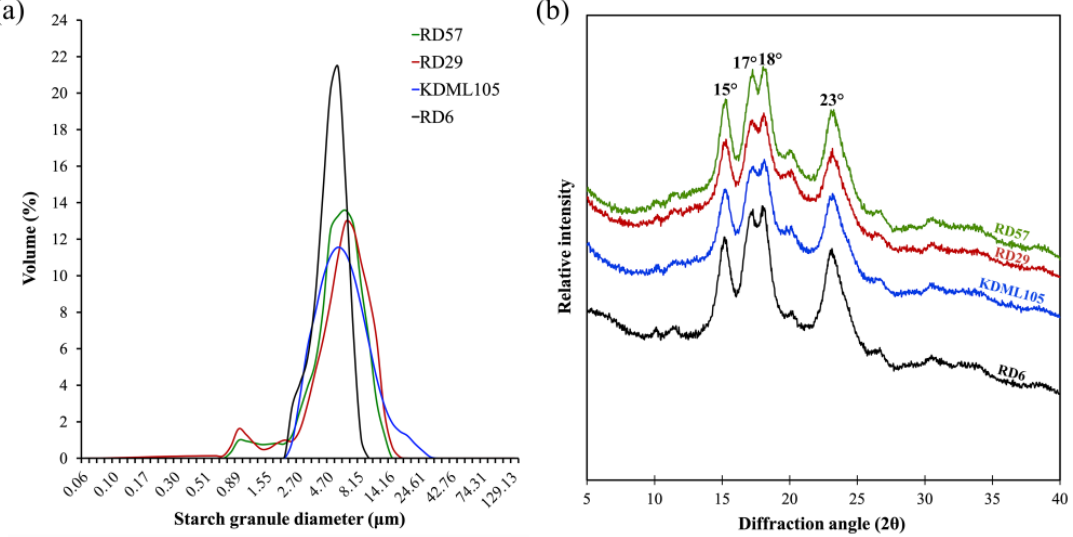
Values are means ± SEM. Means within each column with different superscripts are significantly different ( p ≤ 0.05) by Tukey’s test ( n = 3 for starch granule size distribution and median particle size [d(0.5)] analyses; n = 4 for analyses in degree of crystallinity, swelling power (SP), and solubility (S) of starch granule). Abbreviations: d(0.5) = the granule size at which 50% of all the granules by vol- ume are smaller; SP = swelling power; and S = solubility. S = solubility.